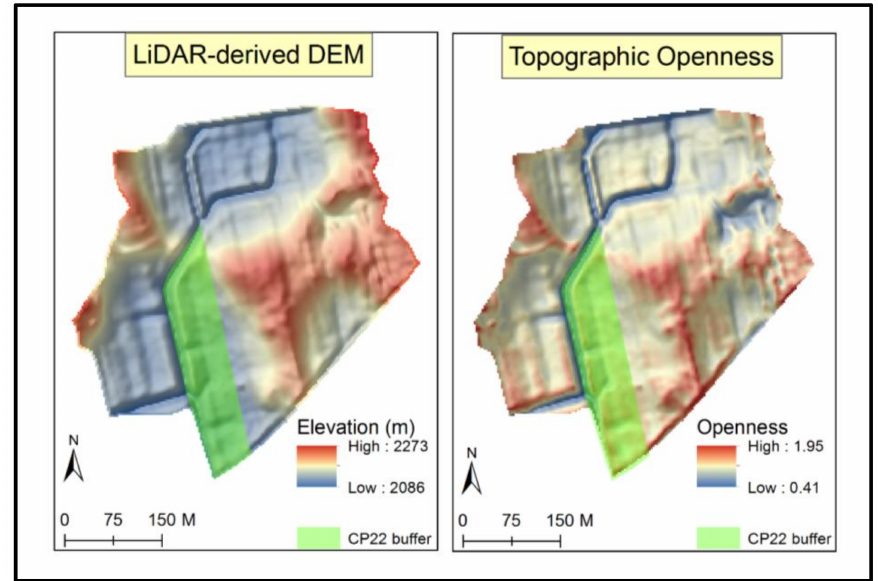
Figure 3. A comparison of the LiDAR-derived digital elevation model (DEM) and the System for Automated Geoscientific Analyses (SAGA) Topographic